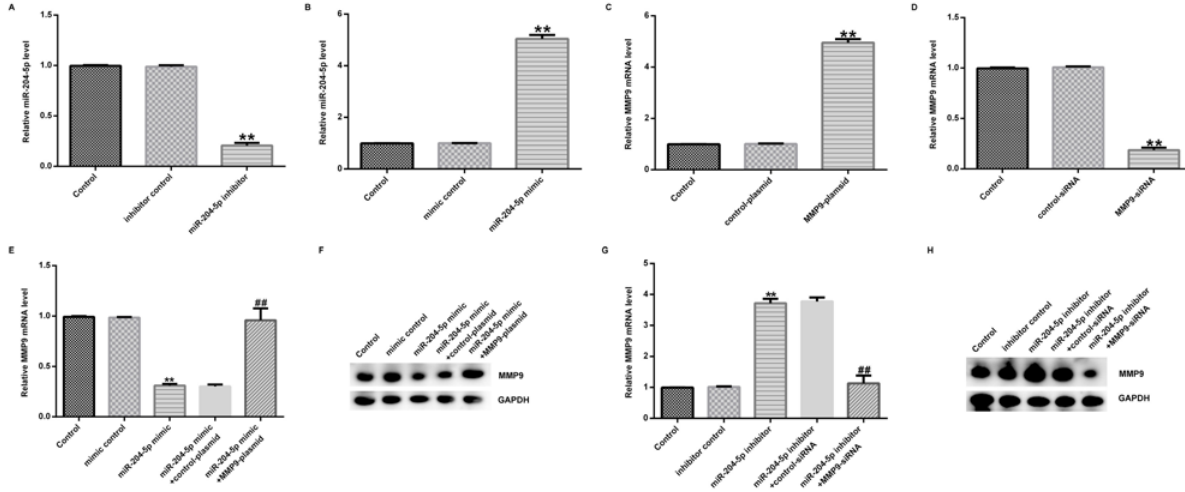
Figure 3: miR-204-5p regulated the expression of MMP-9 in hVSMCs. (A) After transfected with miR-204-5p inhibitor and inhibitor control, the expression of miR-204-5p in hVSMCs was detected by qRT-PCR assay. (B) After transfected with miR-204-5p mimic and mimic control, the expression level of miR-204-5p in hVSMCs was determined by qRT-PCR assay. (C) After transfected with MMP-9-plasmid and control-plasmid, the mRNA expression level of MMP-9 in hVSMCs was deter- mined by qRT-PCR assay. (D) After transfected with MMP9-siRNA and control-siRNA, the mRNA expression level of MMP-9 in hVSMCs was determined by qRT-PCR assay. (E and F) The expressions of MMP-9 were detected by qRT-PCR and Western blot assay in miR-204-5p mimic accompanied by control-plasmid or MMP-9-plasmid groups at both mRNA and protein levels. (G and H) The expressions of MMP-9 were detected by qRT-PCR and Western blot assay in miR-204-5p inhibitor accompanied by control- siRNA or MMP-9-siRNA groups at both mRNA and protein levels. Data presented were the mean ± SD. **p < 0.01 vs. Control group; ## p < 0.01 vs. miR-204-5p mimic/inhibitor group.